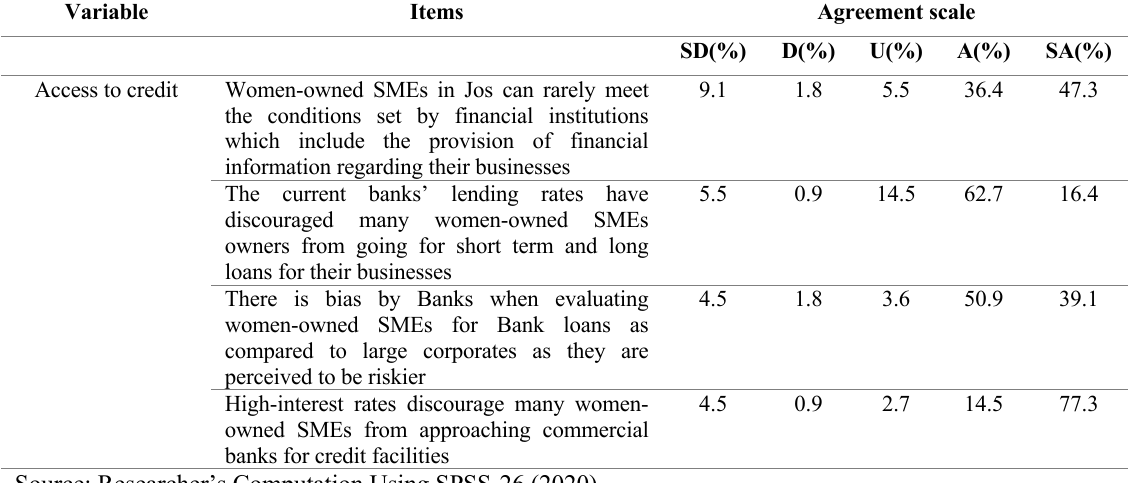
Table 5: Responses to Access to credit.